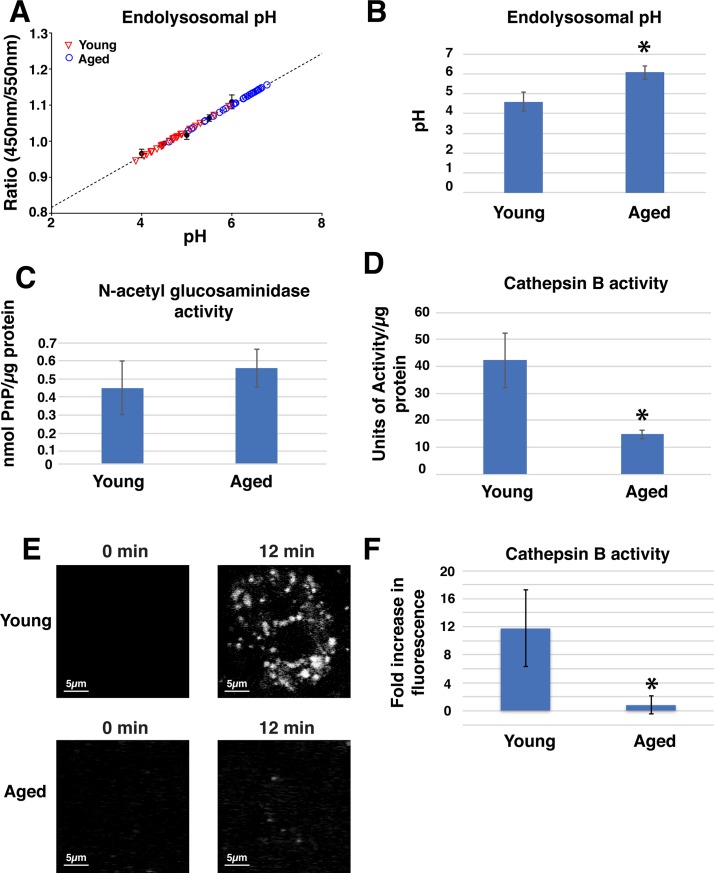
Aging is associated with decreased endolysosome acidification and loss of cathepsin B activity.(A) Lysosensor Yellow/Blue DND-160 fluorescence measurements (ratio of emission readings at 450 nm/550 nm, excitation at 365 nm) of urothelial cells from young (red inverted triangles) or aged (blue open circles) rats were converted to pH readings through use of a standard curve (black closed circles, with dotted linear regression line). Note the tendency for endolysosomal pH to trend towards neutral pH in aged rat urothelial cells as compared to cells from young animals. (B) Summary of endolysosomal pH measurements. (C,D) Activity assays demonstrate that N-acetylglucosaminidase activity (C) is unaffected by age but Cathepsin B activity (D) is significantly decreased in urothelial cell lysates. (E) Magic Red Cathepsin activity in young and aged cells shows time-dependent increase in enzyme activity with young, but not aged cells. Results are quantified in (F). Values in B,C,D, and F represent mean ± standard deviation. Asterisks denote significant differences (p value < 0.05).